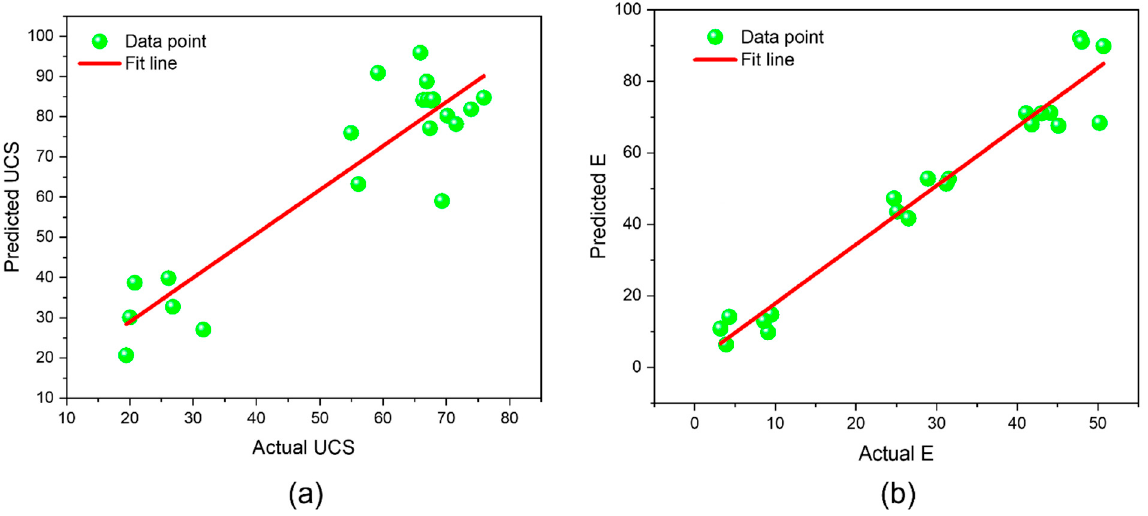
Figure 7. MLR model for actual and predicted UCS ( a ) and E ( b ).